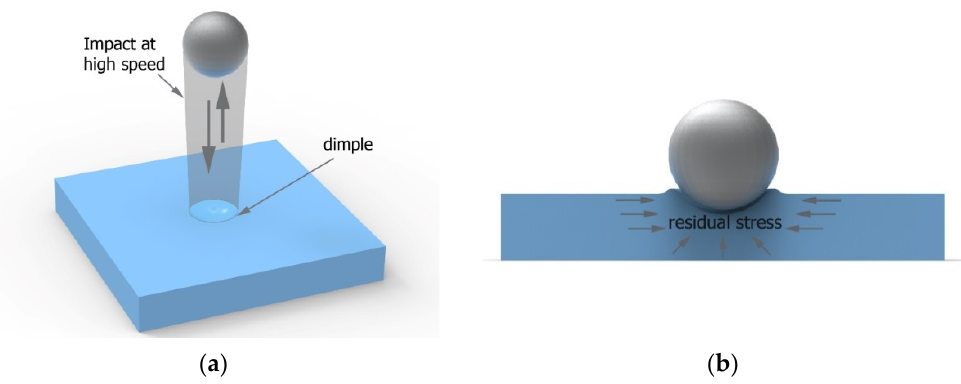
Figure 1. Schematic idea of the shot-peening process ( a ) and residual stress visualization ( b ).